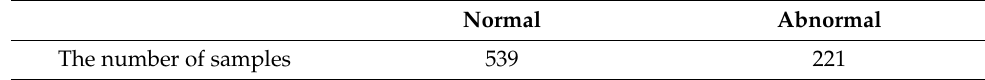
Table 2. The number of individual segments.